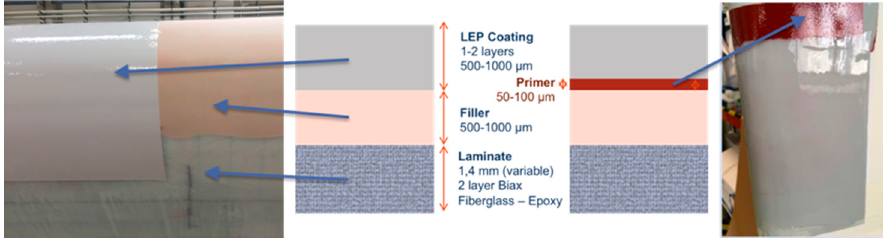
Figure 2. Leading Edge Protection (LEP) system configuration on the blade surface as a post-mould application multilayer system.